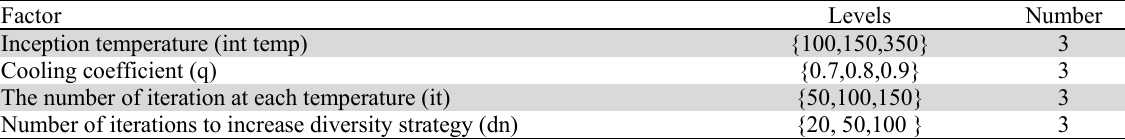
Factor and their levels Factor